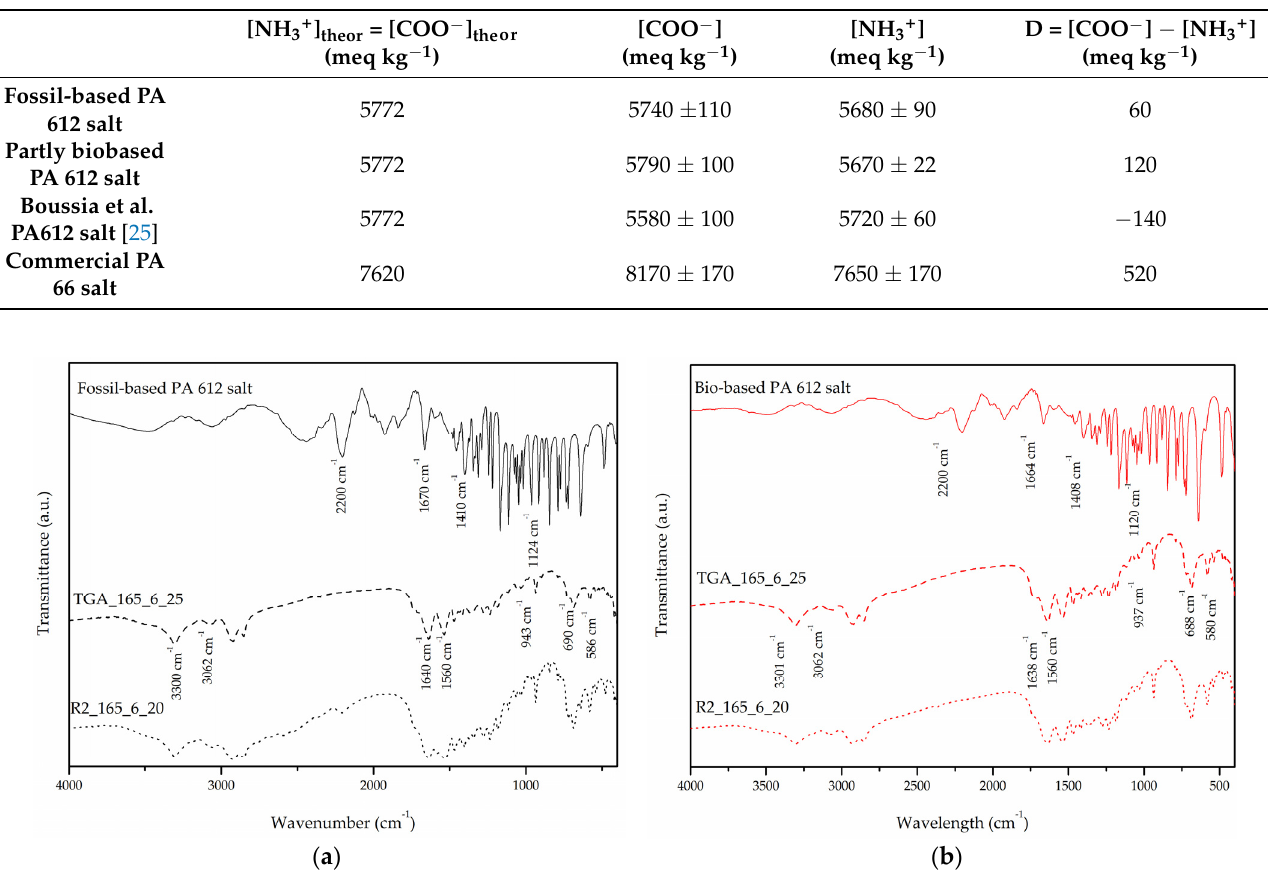
Figure 1. FT-IR spectra of the PA 612 salts and some characteristic DSSP products from both micro scale and laboratory scale runs. ( a ) Fossil- based grade and ( b ) bio-based grade.